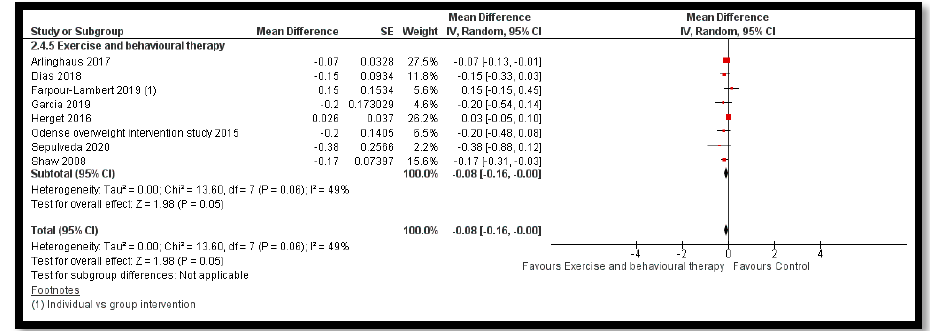
Figure 10. Forest plot for the effect of exercise only interventions for obesity management on body weight .